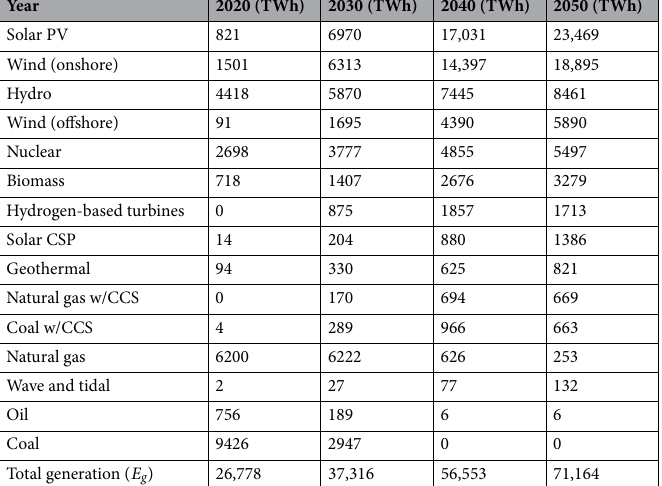
equal shares of wave and tidal power). i Hydrogen-based turbines 63 : 0.841 TWh/km 2 (assuming 3 times more space than that needed for natural gas w/CCS by retrofitting pipelines). The NZE predicts 60% green fuel from electrolysis and 40% blue fuel from natural gas 22 . j Coal w/CCS 3 : 0.793 TWh/km 2 (40% more land use than